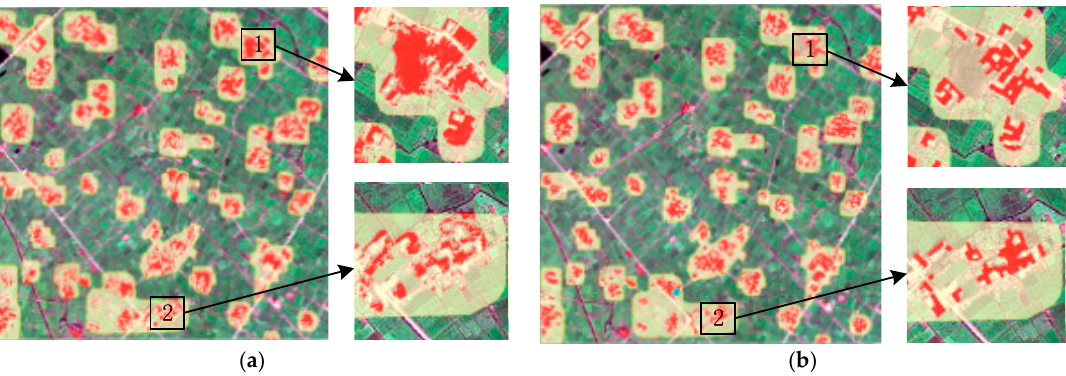
Figure 10. Building results of two compared models: ( a ) “MBI+SR+gCRF”; and ( b ) gCRF_MBI. Table 3. Quantitative evaluation of the building results of the different methods.